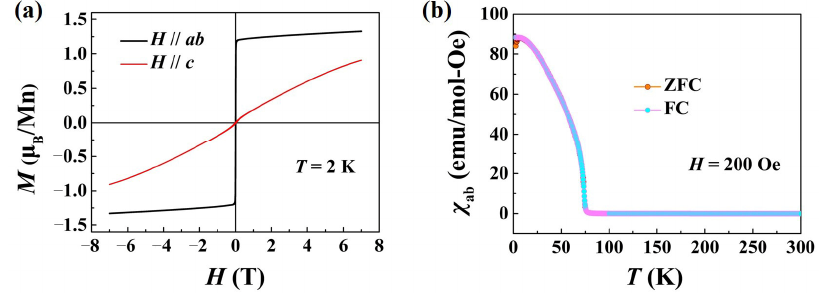
Figure 2. Ferrimagnetic properties of Mn 3 Si 2 Te 6 : ( a ) M - H curves of Mn 3 Si 2 Te 6 bulk crystals at T = 2 K with magnetic fields along the in-plane ( H ∥ ab ) and out-of-plane ( H ∥ c ) directions, respectively. T = 2 K with magnetic fields along the in-plane ( H (cid:107) ab ) and out-of-plane ( H (cid:107) c ) directions, respectively. ( b ) ZFC-FC ( H = 200 Oe, in-plane) curves of Mn 3 Si 2 Te 6 bulk crystals. ( b ) ZFC-FC ( H = 200 Oe, in-plane) curves of Mn 3 Si 2 Te 6 bulk crystals.